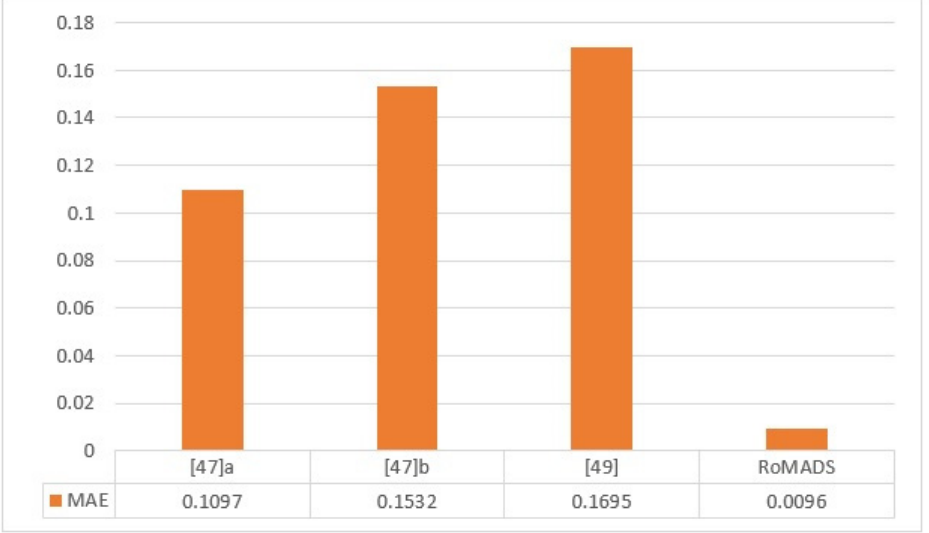
Figure 26. Comparison between RoMADS model result and the previous paper’s results based on MAE.